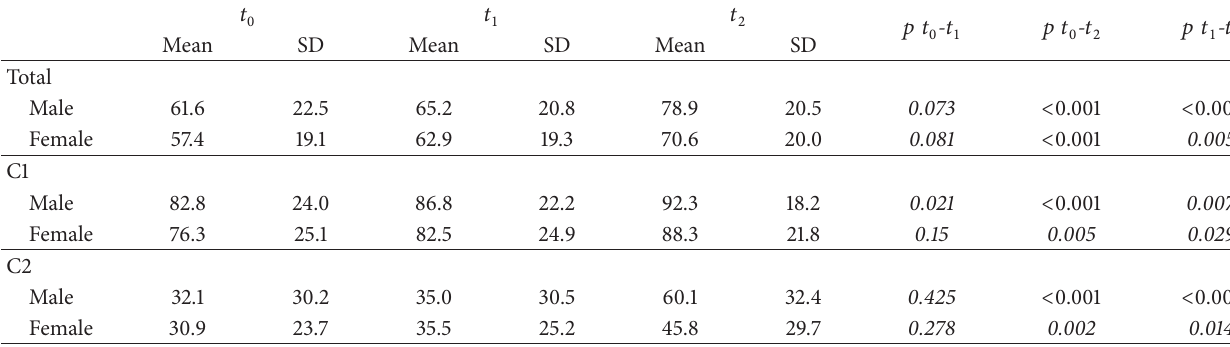
Table 3: Scale results, segmented by sex ( 𝑛 = 88 ).